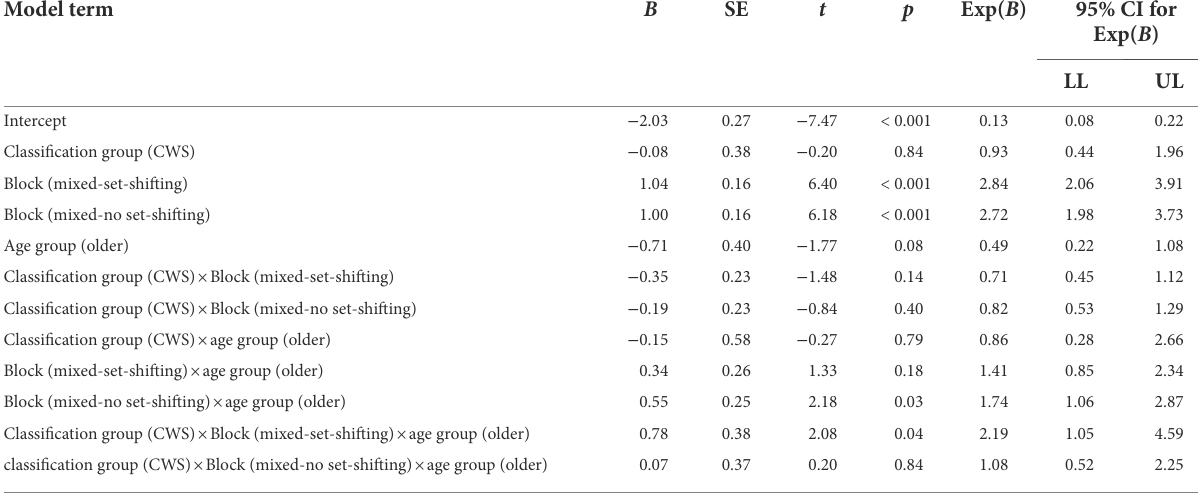
TABLE 4 Fixed coefficients for classification group, age group, and block for the compatible trials analysis of